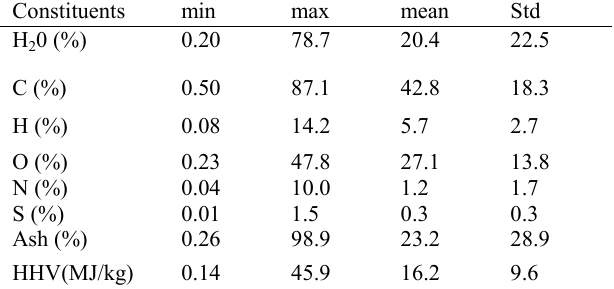
Table 2. Statistical analysis of MSW